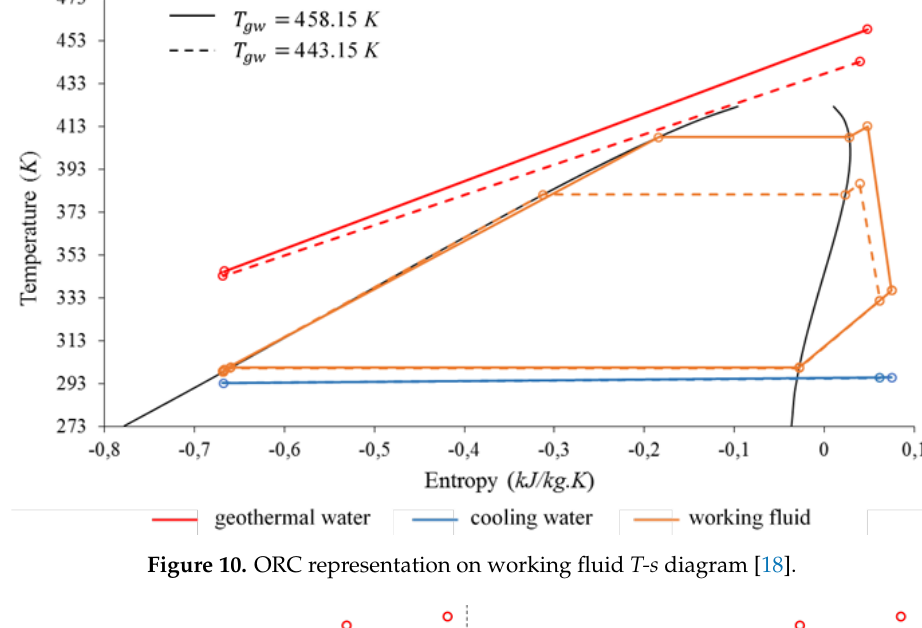
Figure 10. ORC representation on working fluid T-s diagram [18].